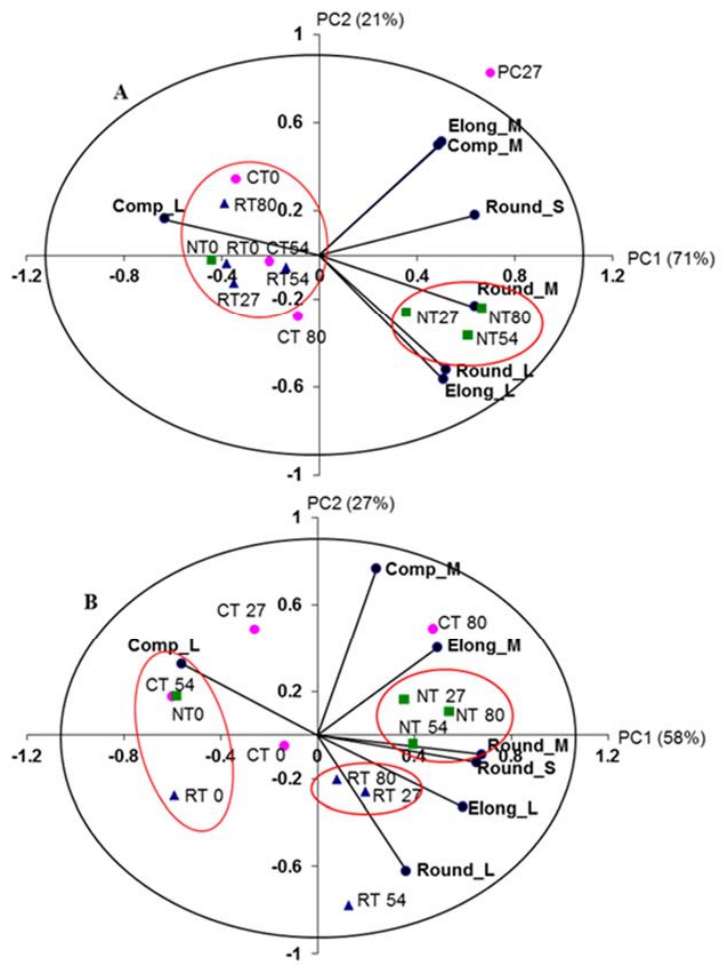
Figure 5. ( A ) PCA for the percentage of pore area in layer 2 for 2009 and ( B ) PCA for the percentage of pore area in layer 2 for 2010, in a Haplic Acrisol, municipality of Piracicaba, São Paulo State, Brazil. Pore shapes (Round: rounded; Elong: elongated; Comp: complex) and sizes (S: 156–15,600 μ m 2 ; M: 15,600–156,000 μ m 2 and L: >156,000 μ m 2 ). PC1: Principal Component 1; PC2: Principal Component 2; CT: Conventional Tillage; RT: Reduced Tillage; NT: No-Tillage: 0, 27, 54 and 80 mm: simulated rainfall